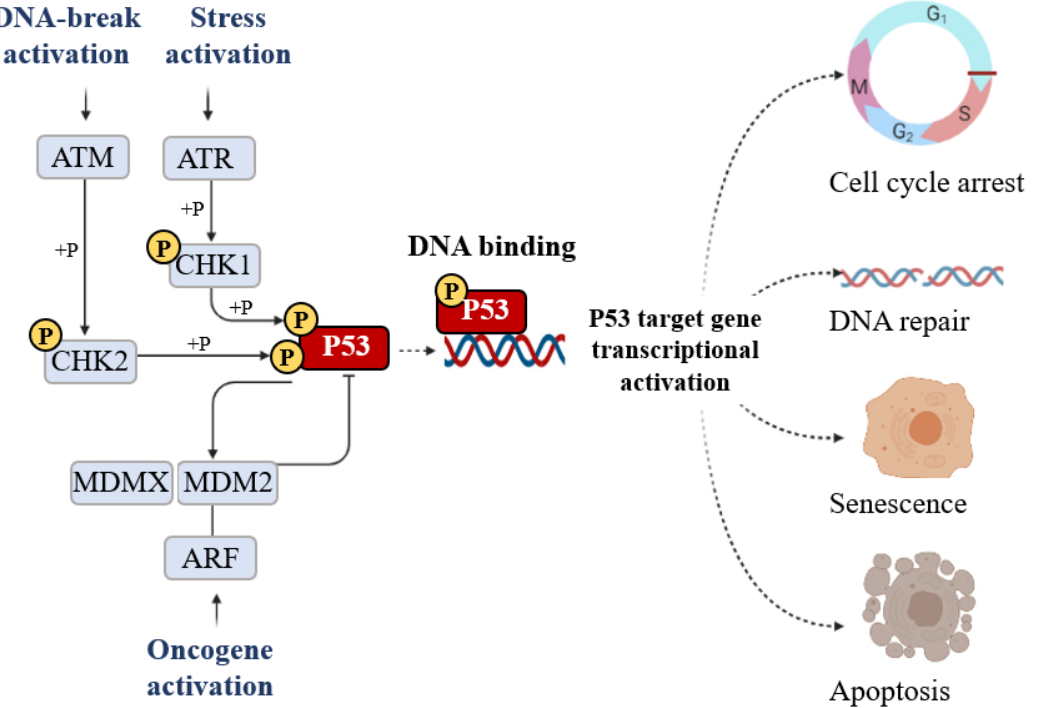
Figure 5. The signal that induces P53 activation is its phosphorylation (+P) which is triggered by DNA breakage activation (ATM), stress activation (ATR), and oncogene activation (ARF). Phosphorylation stabilizes P53 and promotes DNA binding. DNA-bound P53 then recruits the transcriptional machinery to activate the transcription of P53 target genes able of inducing cell cycle arrest, DNA repair, senescence, and apoptosis.